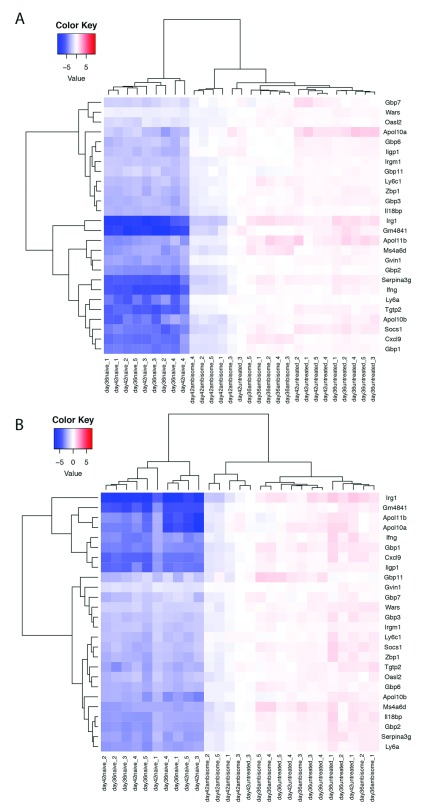
Restoration of 26 gene signature in spleen and liver following AmBisome treatment in
L. donovani infected BALB/c mice.Data is shown in heat map format for the 26 genes identified as a common transcriptional signature of infection in blood, spleen and liver of
L. donovani infected mice
30. Scale represents gene expression values, with no column wise or row wise normalisation applied.
A and
B. The dendrogram illustrates liver (
A) and spleen (
B) data clustered both by the similarity in the pattern of expression per gene (y axis), and by the similarity in gene expression between individuals (x axis).